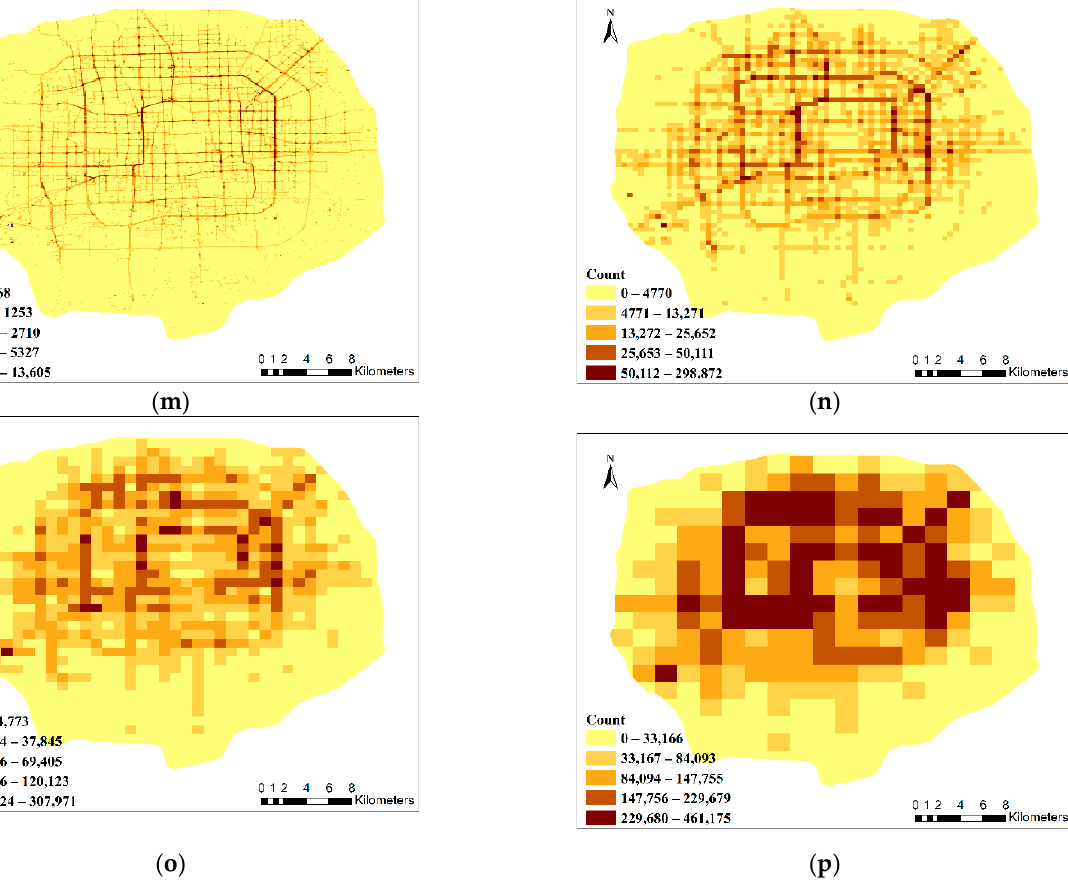
Figure 4. GPS data distributions based on different spatial and temporal units: ( a ) minute/100 m; ( b ) minute/500 m; ( c ) minute/1000 m; ( d ) minute/2000 m; ( e ) hour/100 m; ( f ) hour/500 m; ( g ) hour/1000 m; ( h ) hour/2000 m; ( i ) day/100 m; ( j ) day/500 m; ( k ) day/1000 m; ( l ) day/2000 m; ( m ) two days/100 m; ( n ) two days/500 m; ( o ) two days/1000 m; and ( p ) two days/2000 m.